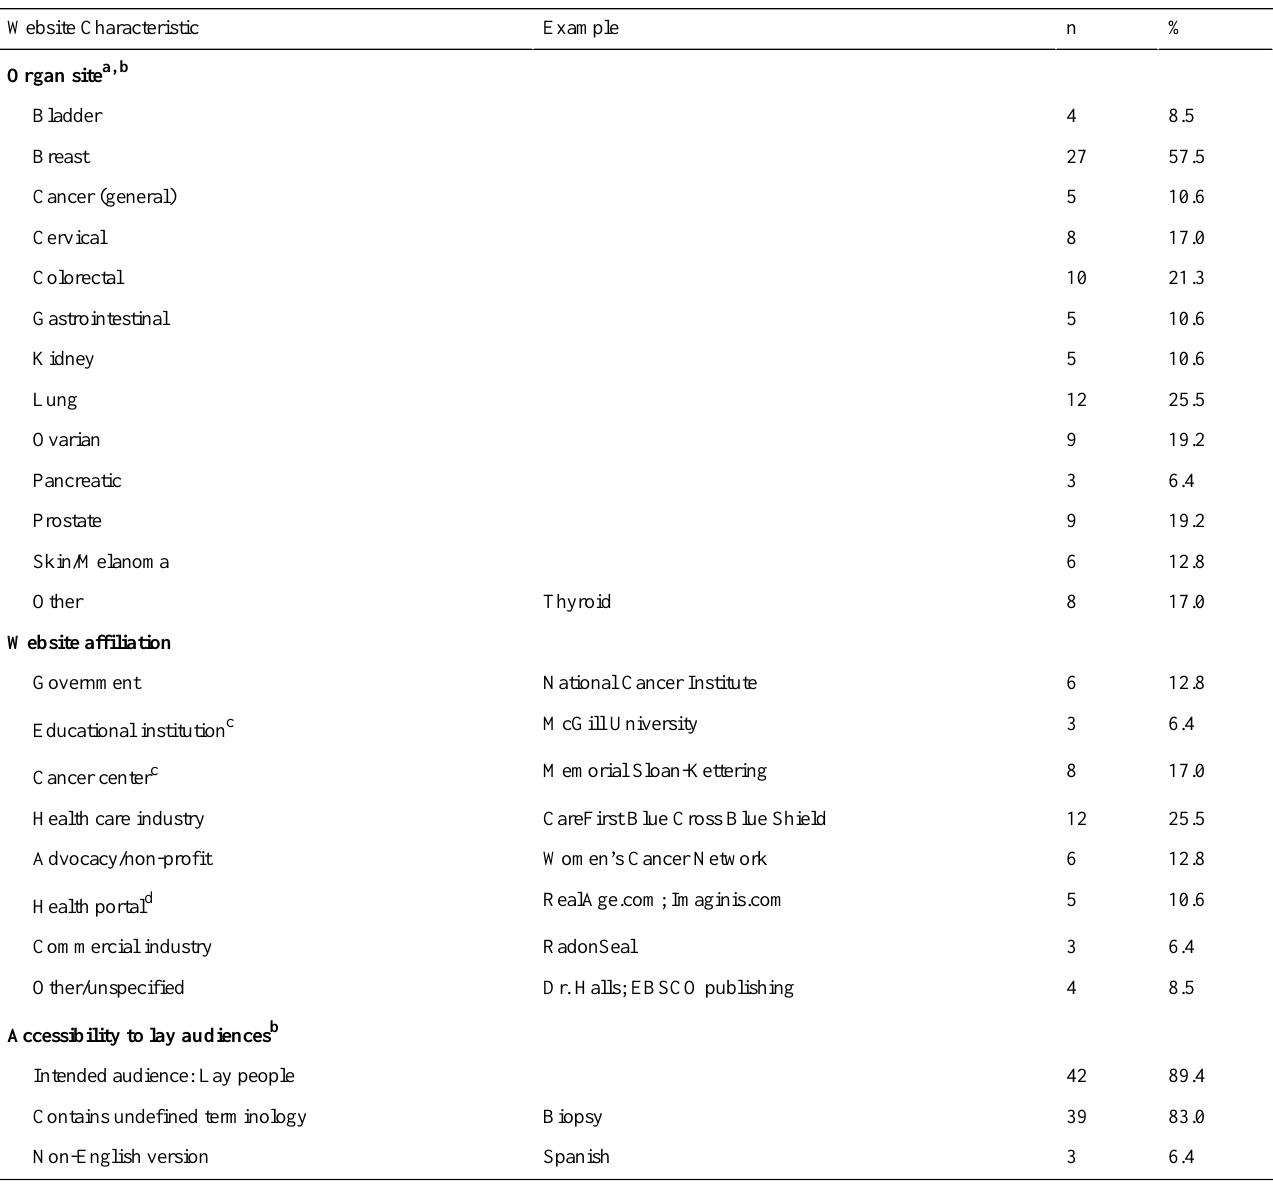
Table 4. General website characteristics (N =